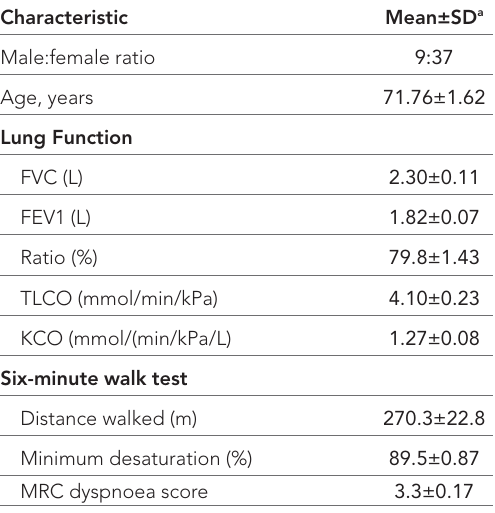
Table 2 Baseline characteristics of BILD patients with NF- induced interstitial lung disease (NFILD).